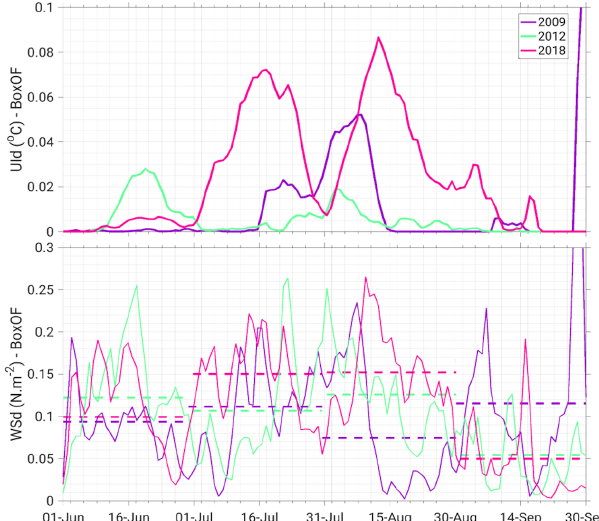
Figure 15. Same as Fig. 9 for BoxOF and years 2009 (purple), 2012 (green), and 2018 (magenta). For the sake of readability, the y axis is cut off for the last extreme value of September 2009, which cor- responds to the passage of storm Ketsana over the SVU region (see the NOAA storm track website at https://coast.noaa.gov/hurricanes, last access: 25 July